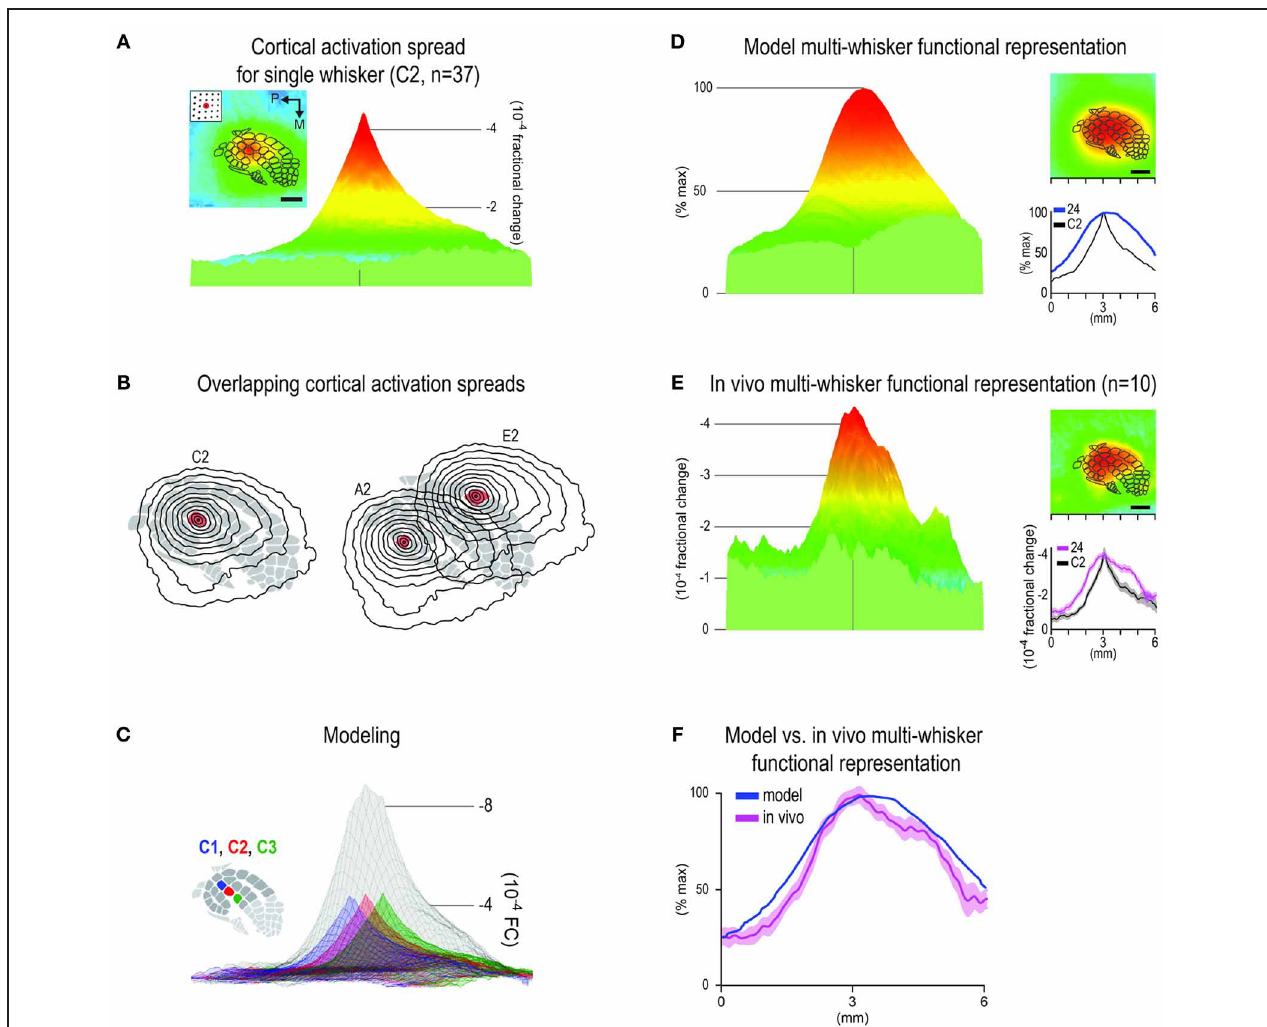
which three copies of the representative SWFR are aligned according to C1 (blue), C2 (red), or C3 (green) barrel location before their linear summation to generate the model-MWFR for whiskers C1–C3 (gray). (D–F) Model- vs. in vivo -MWFR for the 24-whiskers array. (D) Model-MWFR for 24-whiskers for same 6 × 6mm field-of-view plotted in 3D (parent panel) or 2D (top inset), or as a line plot for the rostral-caudal slice through the center of C2 whisker barrel (bottom inset), blue trace; black trace is for the representative SWFR in (A) . (E) Average in vivo -MWFR for 24-whiskers in Figures 3A–C is shown here for easier comparison to the model-MWFR provided in (D) . Note that the model-MWFR exhibited many of the salient properties observed for the in vivo -MWFR: symmetrical activity mountain with one central peak; peak location aligned with that for whisker C2 and thus located centrally within barrel cortex; a relatively broader mountain shape compared to whisker C2. (F) Response magnitudes for the rostral-caudal slice through the center of whisker C2 barrel are plotted to illustrate the goodness-of-fit between the normalized model- vs. in vivo